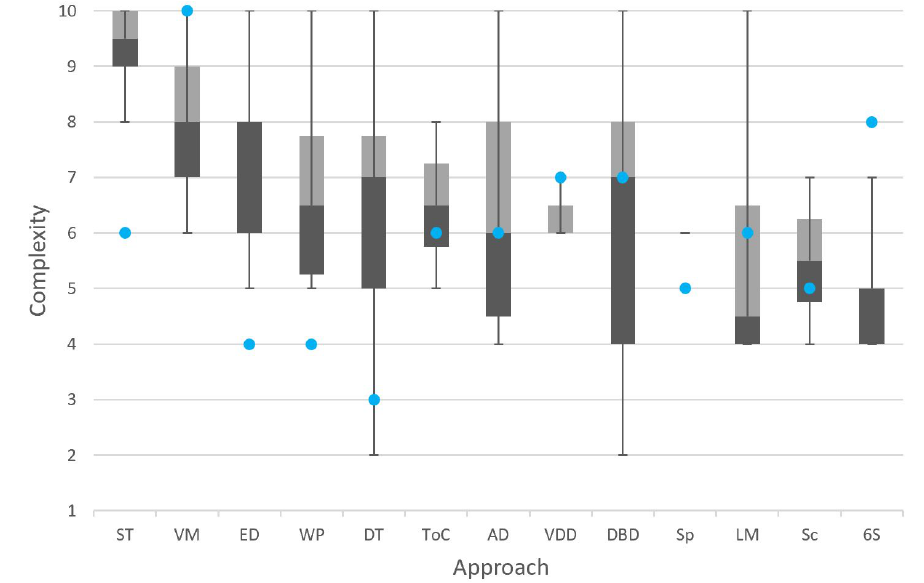
Figure 5. Complexity level of problem that each approach is relevant to. Shaded boxes span the interquartile range, separated by the median. Error bars represent upper and lower extremes. Blue dots represent the authors’ initial classification. Approaches are ordered by decreasing mean.